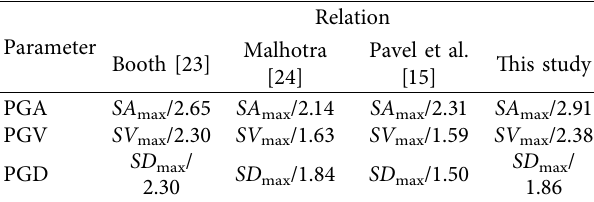
Figure 4: Comparison between the maximum spectral accelerations of the ground motion recordings in the database and the design spectral accelerations from the codes P100-1/2013 [19] and Eurocode 8 [10]. Table 2: Comparison between the empirical relations for the computation of the peak ground acceleration, velocity, and dis- placement from various studies.